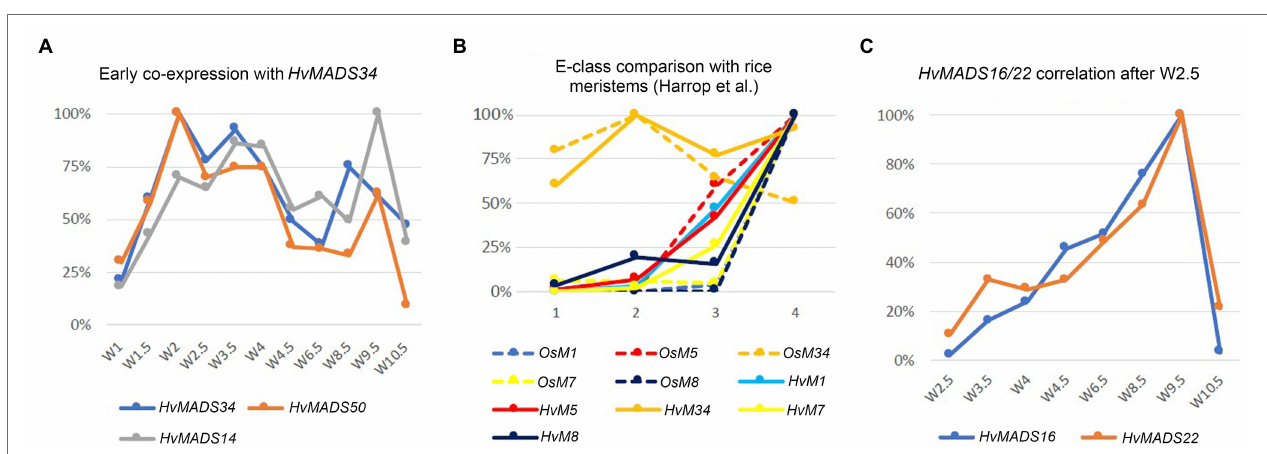
FIGURE 7 | Co-expression within barley or with equivalent stages in rice can suggest related functions. (A) Early co-expression of HvMADS34 with HvMADS14 (A-class) and HvMADS50 (SOC1-like). (B) Comparison of early E-class gene expression in barley and rice. Analysis of the differential gene expression in the inflorescence meristem types of rice using laser microdissection followed by RNA sequencing (dashed lines) from the supplemental data of Harrop et al. (2016). While directly comparing the results of their work with expression in the early stages of the whole barley inflorescence meristem is a false equivalency, it can still provide some insights. The best matching Waddington stages W1.5–W3.5 expression data are shown (solid lines; this paper). On the x -axis, 1 is inflorescence meristem/W1.5, 2 is branch meristem/W2, 3 is elongated branch meristem/W2.5 and 4 is spikelet meristem/W3.5. (C) Correlation of the relative expression of HvMADS22 and HvMADS16 between W2.5 and